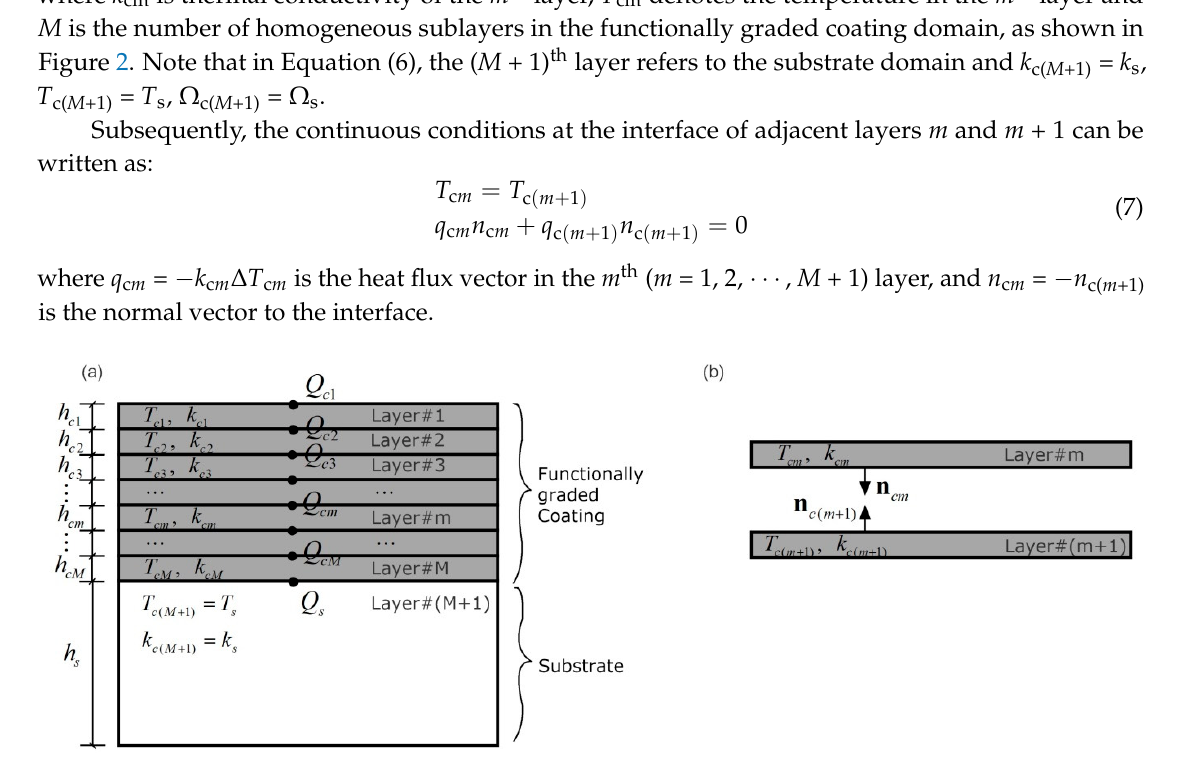
Figure 2. Schematic diagrams of ( a ) the multi-layered coating/substrate system, and ( b ) the adjacent layers.